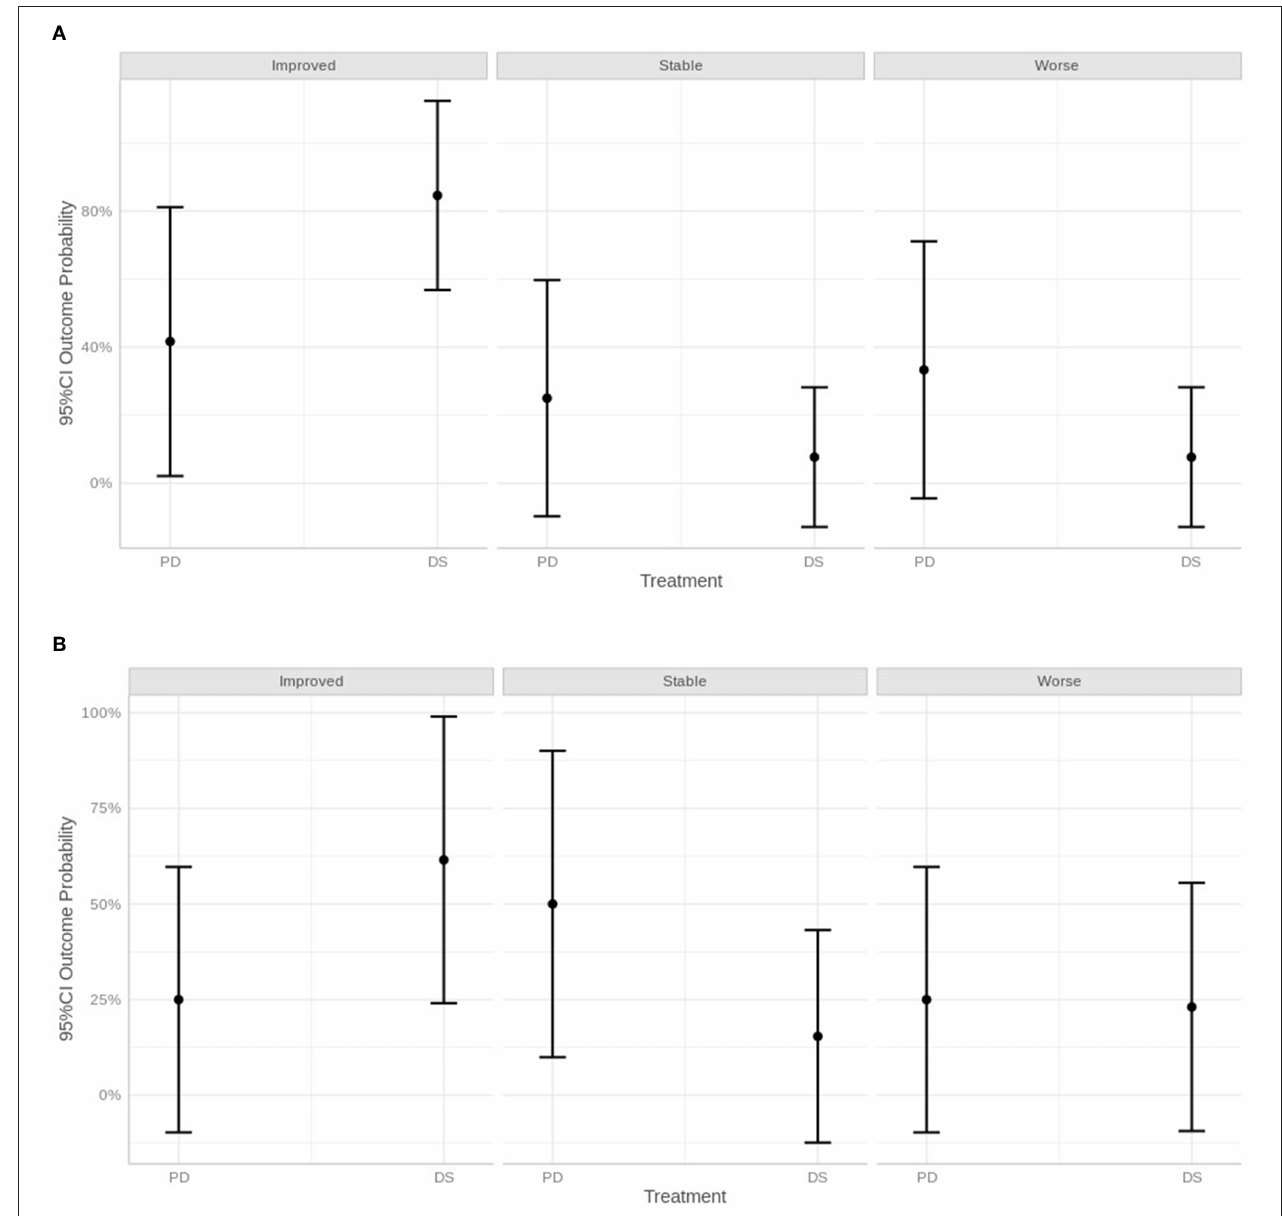
FIGURE 7 | Graphical representation of neurological status within 30 days of surgery (A) , after 30 days and within 1 year (B) and over 1 year, defined as improved, stable, or worse.